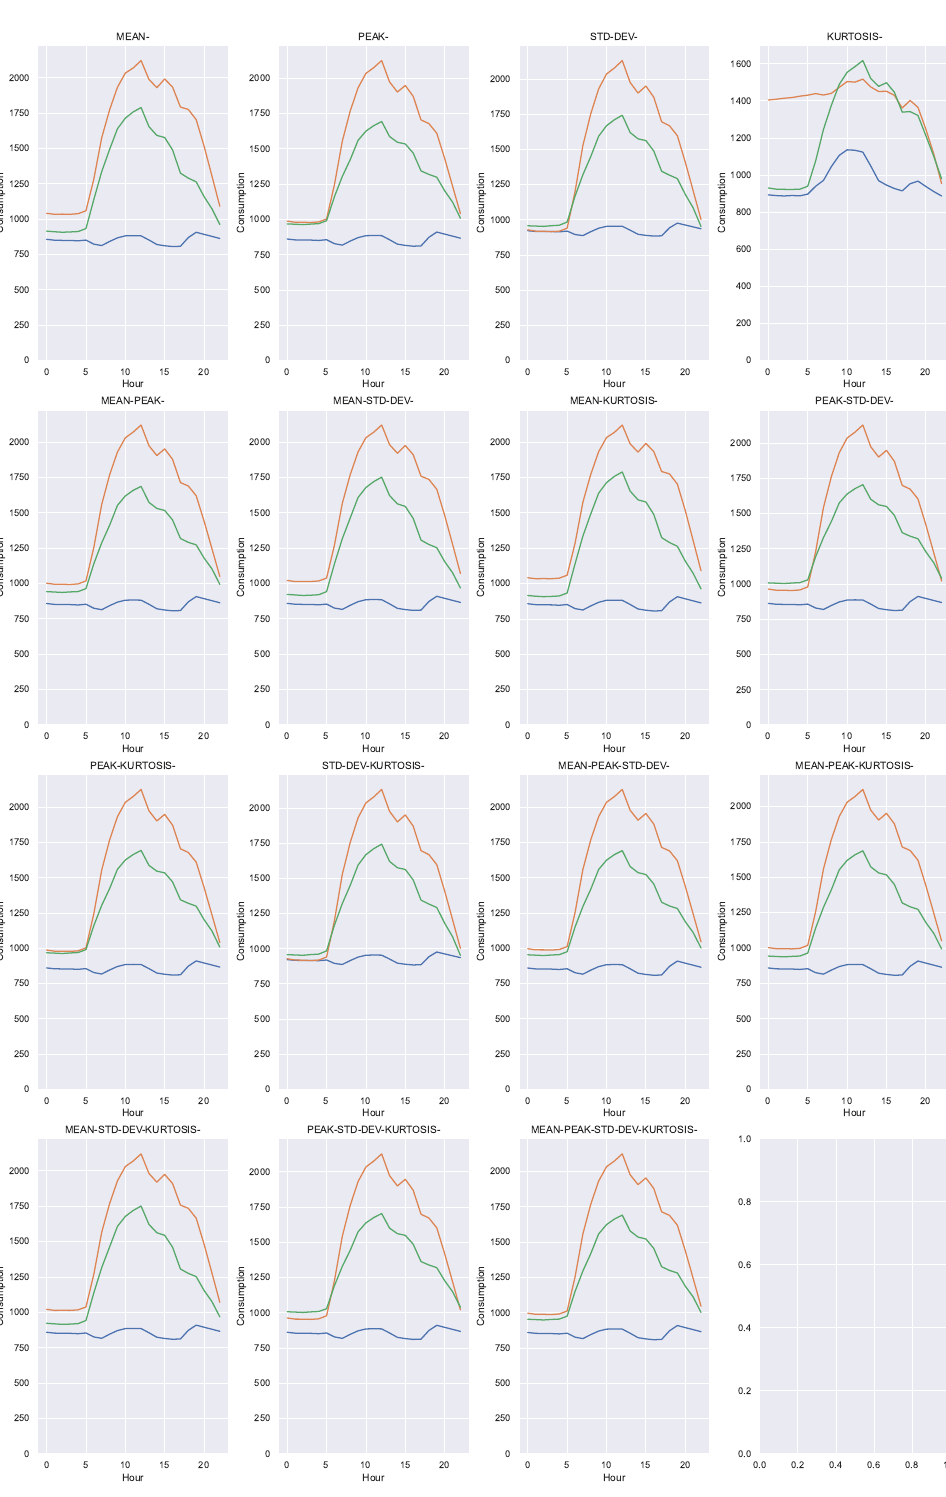
Figure 9. Cluster prototypes for each combination of geometric indicators. Each color represents a single